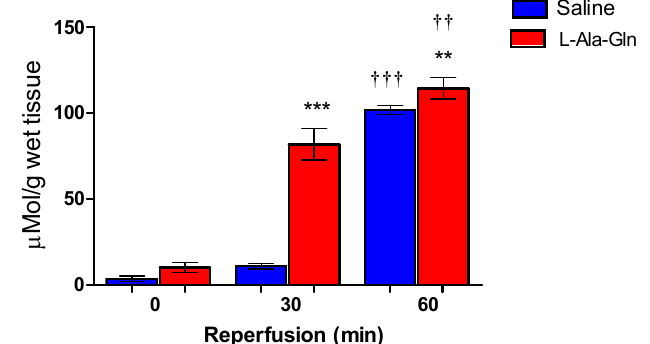
FIGURE 2 - Reduced glutathione levels (micromoles per gram of fresh tissue) in cerebral tissue of saline and Ala-Gln pretreated gerbils. Bars represent means±SD of control (blue bars) and L-Ala-Gln (red bars) groups at the end of the ischemia (0 min) and during reperfusion (30 and 60 minutes). L-Ala-Gln group is significantly different from control group (p<0.05) at 30 minutes, by ANOVA/Tukey test.**P<0,01 and ***p<0.001 compared with T-0, group G. †† P<0,01 and ††† P<0.001 compared with T0, same group.